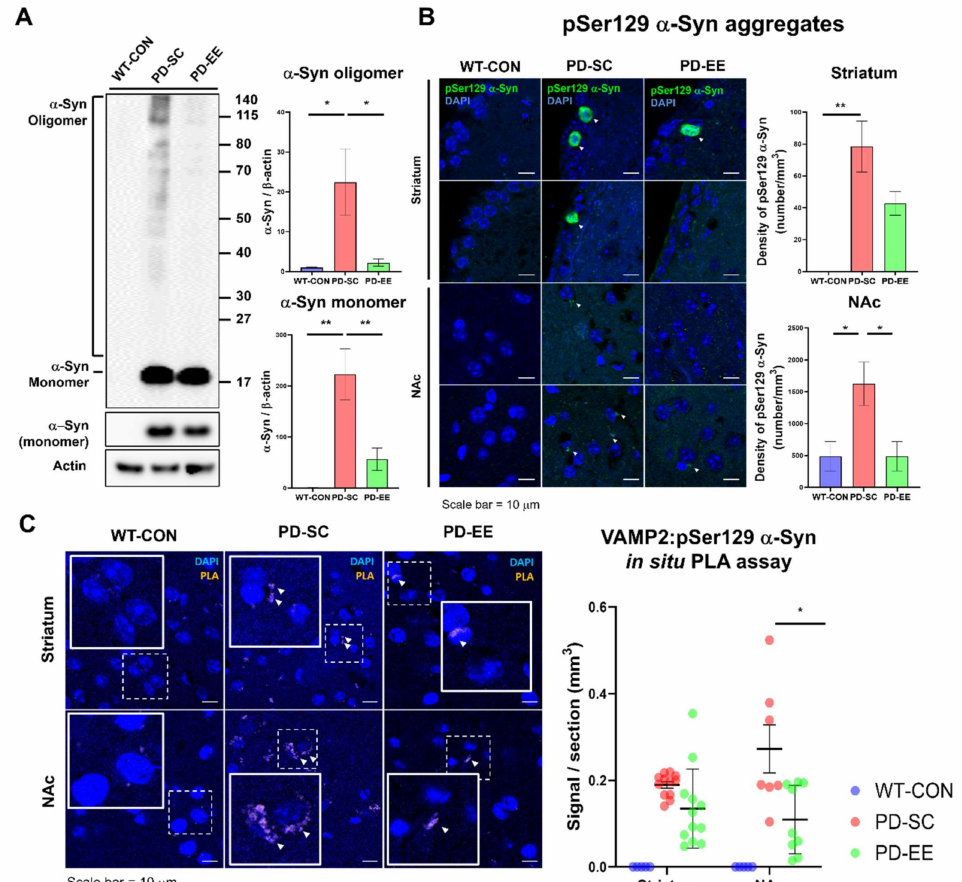
Figure 4. EE reduced the levels of aggregated α -Syn and the interaction between α -Syn and VAMP-2 in the NAc of hA53T α -Syn-overexpressing transgenic mice. ( A ) Western blot results indicated the relative expression levels of the α -Syn monomer and oligomer. The expression of the α -Syn monomer tended to increase but that of aggregated α -Syn decreased in samples from mice in the PD-EE group, compared to those in the samples from mice in the PD-SC group ( n = 5, each). ( B ) Representative images of pSer129 α -Syn immunohistochemistry in the striatum and NAc of the mice from three groups. The density of pSer129 α -Syn tended to decrease in samples from mice in the PD-EE group compared to that in the samples from mice in the PD-SC group in both regions (scale bar = 10 µ m, striatum: WT control group (WT-CON), n = 5; PD-SC, n = 8; PD-EE, n = 6; NAc: WT-CON, n = 5; PD-SC, n = 6; PD-EE, n = 5). ( C ) The proximity of VAMP2 and pSer129 α -Syn in the striatum and NAc, assessed by proximity ligation assay, showed decreased PLA signals in samples from mice in the PD-EE group, relative to that in samples from mice in the PD-SC group (scale bar = 10 µ m, striatum: n = 4 each; NAc: WT-CON, n = 4; PD-SC, n = 3; PD-EE, n = 3). * p < 0.05 and ** p < 0.01 versus WT-CON; one-way ANOVA followed by post-hoc comparison. Data in all panels represent the mean ±